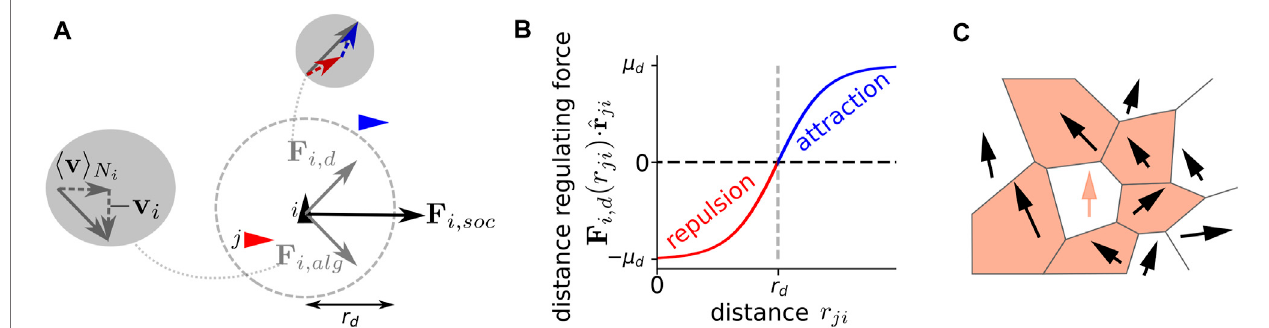
FIGURE 1 | Implementation of social interactions. A focal agent (black triangle) responds to neighbors (red and blue triangle) via a velocity alignment force F i,alg , which aims at minimizing the velocity difference to the mean neighbor velocity 〈 v 〉 N , and a distance regulating force F i,d , their sum corresponds to the social force F i,soc i (A) . For simplicity the distance regulating force has a sigmoidal distance dependence: it is repulsive for distances closer, attractive for distances larger than a preferred distance r d (A,B) . Note, the sign of the projection of F i,d onto the distance vector ^ r ji de fi nes the direction towards (+) or away ( − ) from the respective neighbor j . The neighborhood of a focal agent (red arrow) is de fi ned by its Voronoi neighbors (black arrows in red cells, C